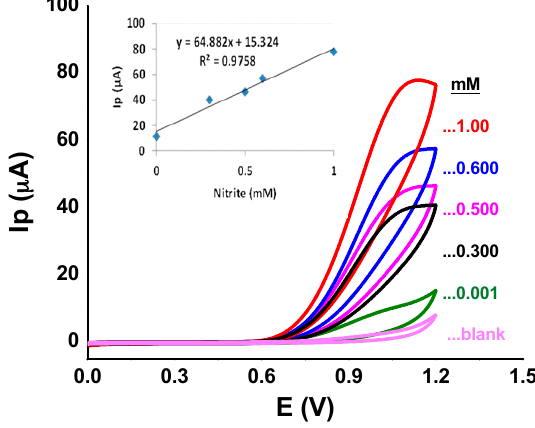
Figure 6. CVs obtained with the Px-CuO NSs-modified GCE and scan rate of 100 mV s − 1 in phosphate buffer (pH 7.0), illustrating the change in peak current as a function of nitrite concentration over the range 0.001–1.0 mM. The inset shows the corresponding linear plot.